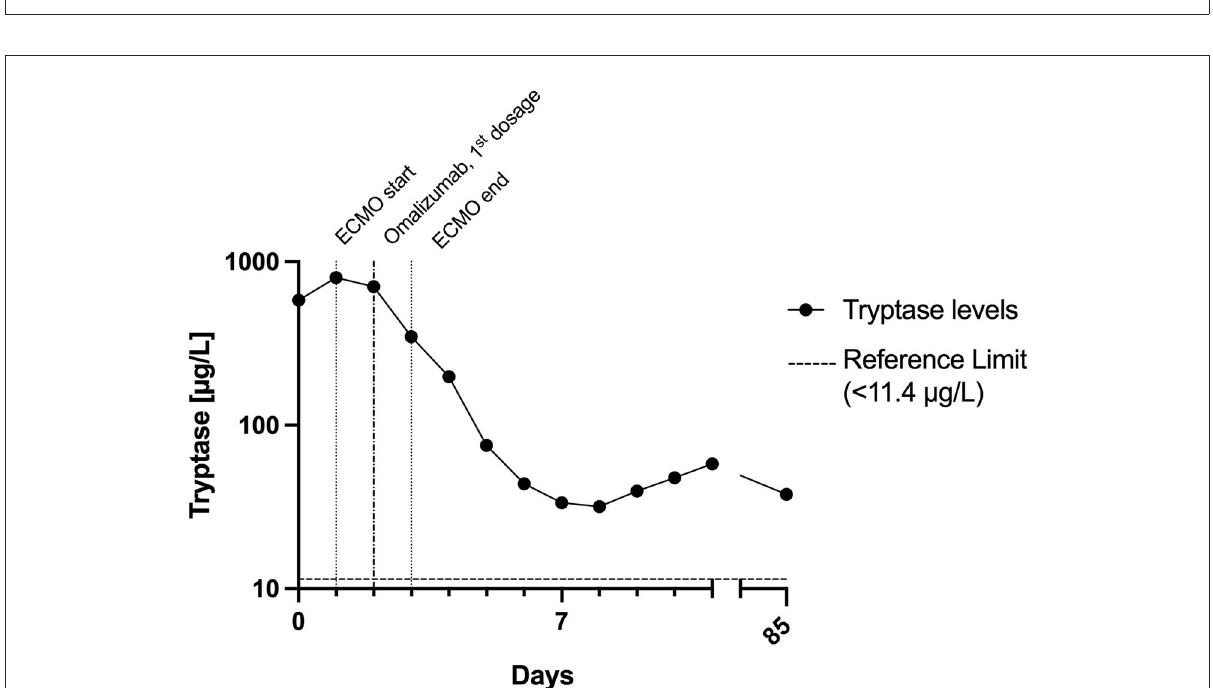
FIGURE2 Time course of tryptase levels within the first days and follow-up. The half-life of tryptase between days 2 and 5 was about 32h. This is in stark contrast to the normal tryptase half-life of 2 h. This indicates ongoing mast cell activation for a couple of days after the initial peak. ECMO, extracorporeal membrane